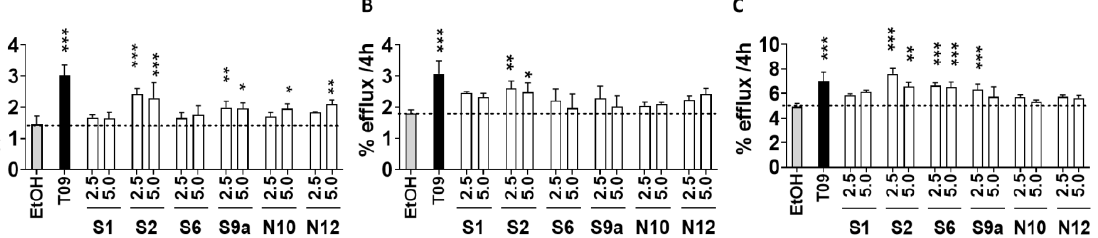
Figure 5. Effect of LXR ligands on cholesterol efflux from HepG2 cells. HepG2 cells were loaded for 24 h with 2 μCi /mL [ 3 H] cholesterol in the presence of 1% FCS and then incubated for 20 h with vehicle (ethanol), 2.5 μM or 5 μM LXR ligands. Cholesterol efflux was promoted to ( A ) human APOA1 (10 µg/mL), ( B ) human HDL (12.5 µg/mL), and ( C ) a pool of serum from normolipidemic individuals at 2% ( v/v ) for 4 h and assayed as described under Methods. Each cell treatment was performed in triplicate and data are expressed in percentage as mean ± SD ( n = 3). Significance is compared to the control (EtOH) value: * p ≤ 0.05, ** p ≤ 0.01, *** p ≤ 0.001.